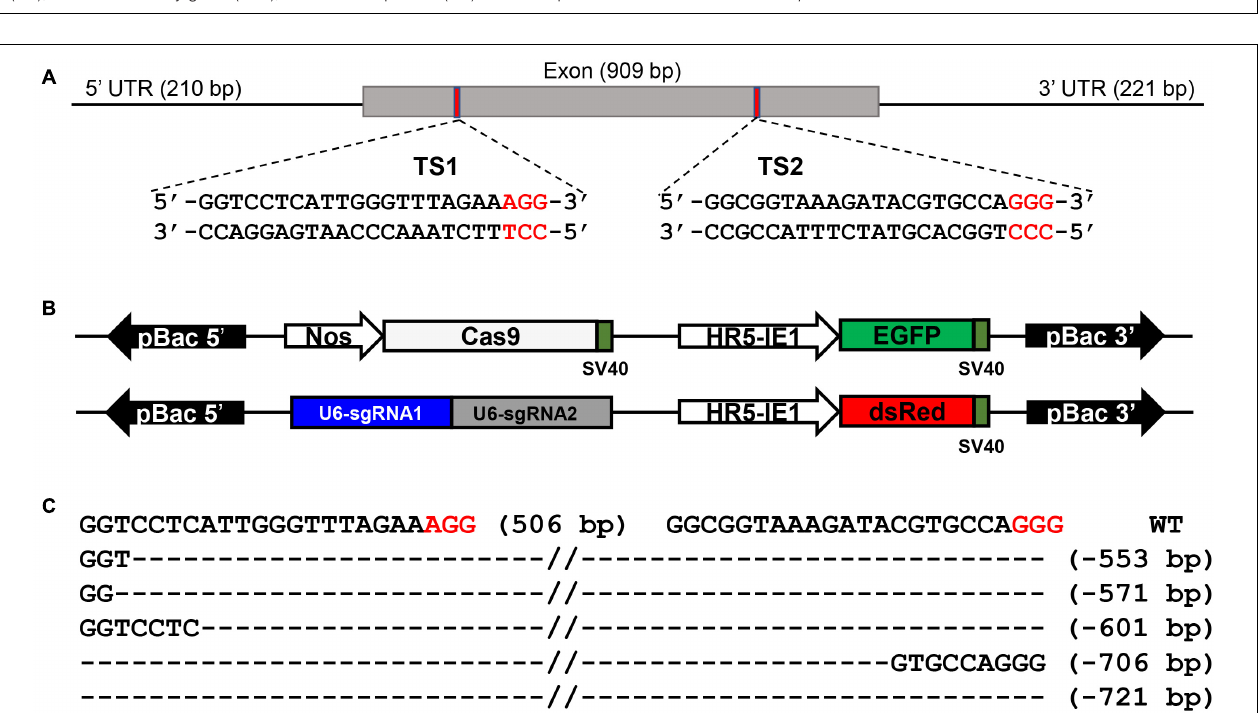
FIGURE 3 | BmSer1 knockout mediated by transgenic CRISPR/Cas9 system. (A) Genomic structure of BmSer1 . The locations and sequences of the binding sites for sgRNAs (TS1 and TS2) in the exon of BmSer1 are indicated. (B) Schematic representations the activator line vector Nos-Cas9 and effector line vector U6-sgRNA . (C) Mutations observed in representative heterozygous offspring. The target sequence is in black, and the PAM sequences are in red. The deletion size is indicated to the right of the sequence.